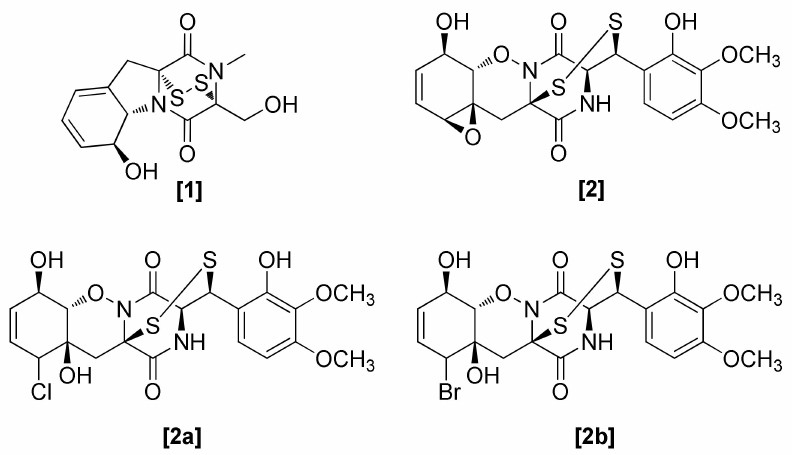
Figure 1. Structures of diketopiperazines from Trichoderma spp.: [1] gliotoxin isolated from Trichoderma lignorum , [2] gliovirin isolated from T. virens , [2a, 2b] analogues of gliovirin isolated from T.